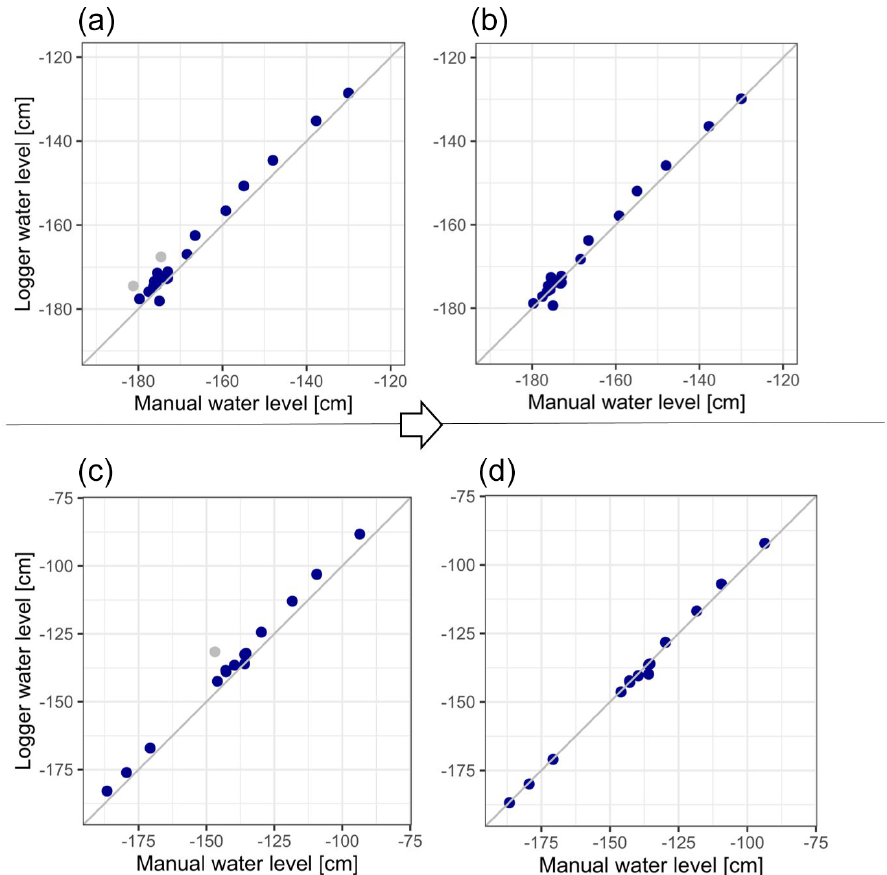
Figure 5. Relation between the manual and logger water-level measurements (in cm) below the top of the well before (a, c) and after (b, d) the re-calibration of the logger for well A7 (a, b) and well B18 (c, d) . Manual measurements that were identified as outliers are marked in gray (in panels a and c ). The correction factor (i.e., intercept) was − 1.2cm for well A7 and − 3.9cm for well B18.